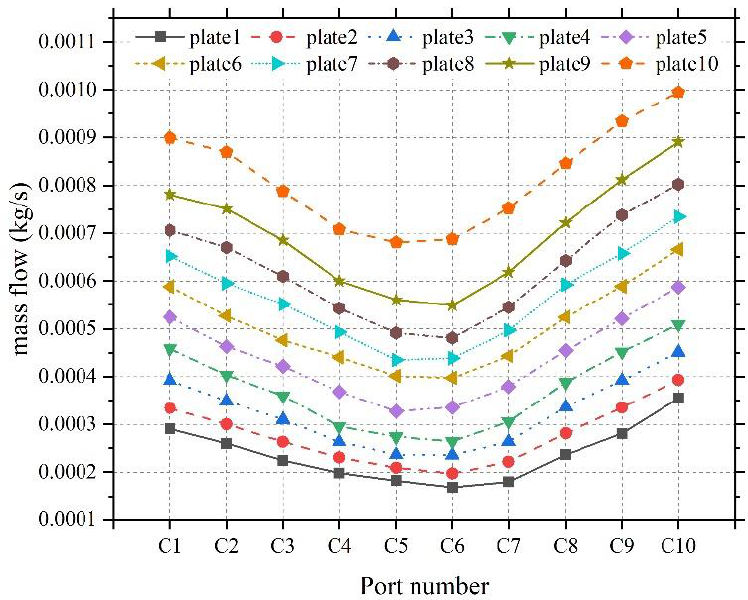
Figure 5. Statistical diagram of the flow distribution in each channel.